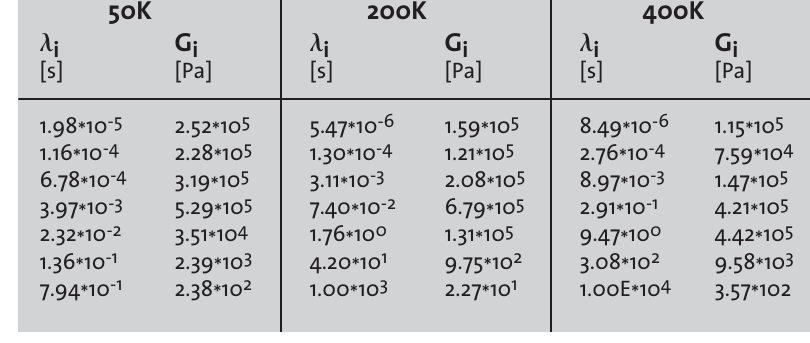
Table 2: Relaxation spectra of samples used in this